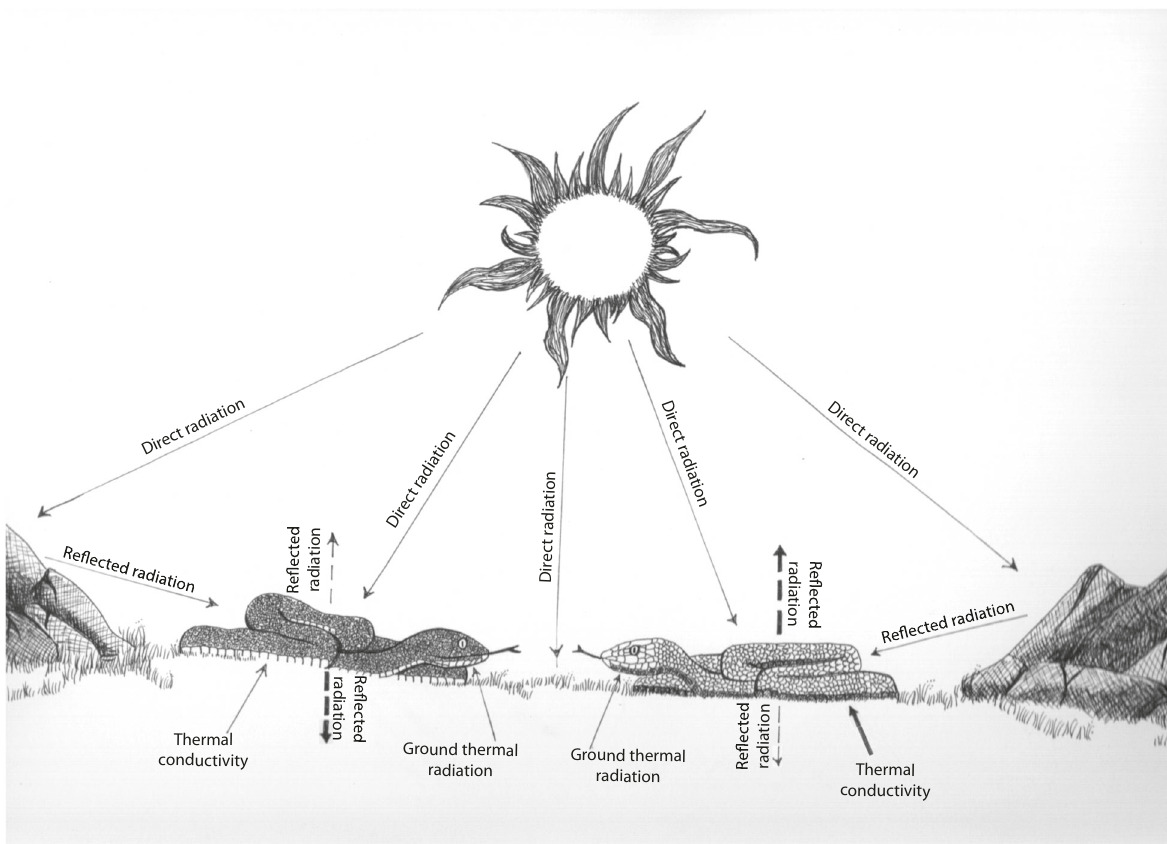
Fig. 1 Flow of energy between direct-and-indirect solar radiations and the organism. Here, we assumed convective heat exchanges (i.e., wind), evaporative cooling from metabolism, food uptake, and urine/faeces production to be constant. The formulated model is a simpli fi cation and presented in a conceptual manner to re fl ect our hypothesis. The direct solar radiation contains all energy-rich radiations, spanning from the UV-visible (300 – 700 nm) to the near infrared (NIR: 700 – 2500 nm). The re fl ected radiation and the ground thermal radiation contain IR energy. The ground thermal radiation and the thermal conductivity increase with the increase of direct solar radiation. However, different grounds present different speci fi c heat capacities ( c p ), which ultimately affect the amount of heat released by the substrate. Solid lines represent the energy received by the organism; dashed lines represent the energy re fl ected by the organism. Thicker dashed lines indicate high re fl ectance; thinner dashed line show low re fl ectance. Given the unique properties of melanin (see main text), we reasoned that a brighter integument will re fl ect more direct or indirect solar energy, while a darker integument will absorb more direct or indirect solar energy. Adapted from Porter & Gates 13 and Porter et al. 89 . Drawing: Karen